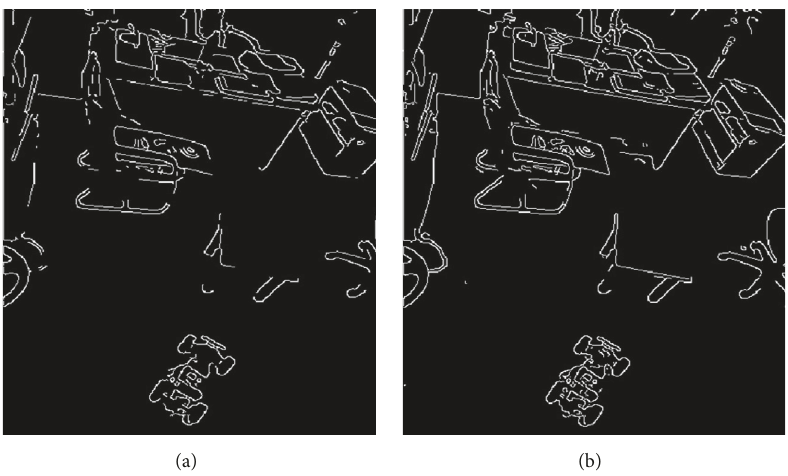
Figure 22: Comparison results for third tested image.